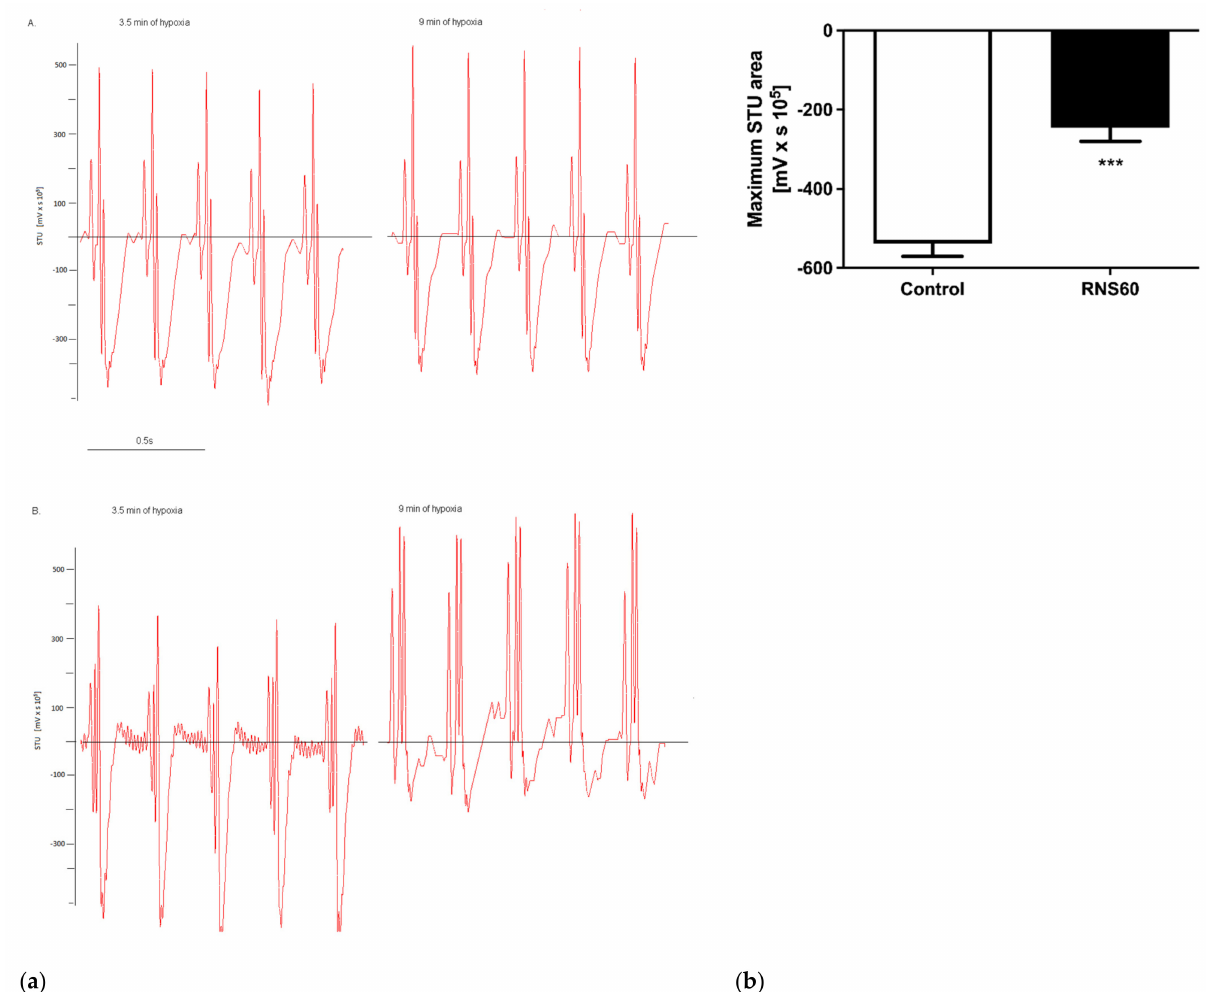
Figure 1. ECG. ( a ) A. At 3.5 min of hypoxic stress. B. At 9 min of hypoxic stress. ( b ) STU area in the 9th min of hypoxic stress in ApoE − / − LDLr − / − mice that received the intravenous injection of RNS60 or saline as the control. Values represent mean ± SEM (n = 5); *** p < 0.0001.